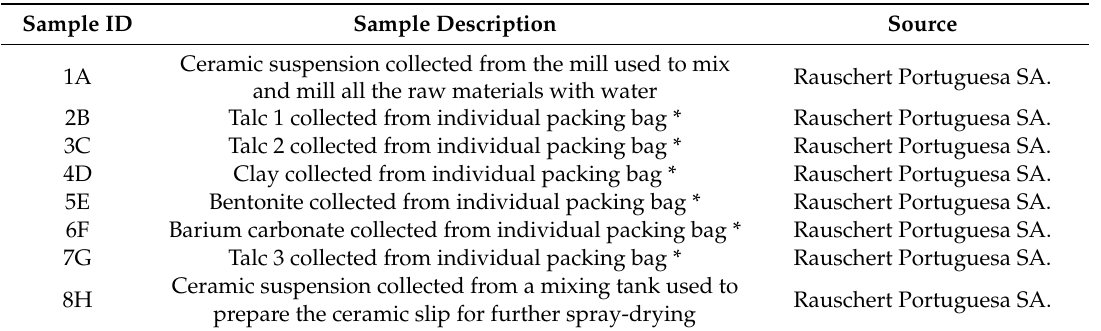
Table 1. Description and characteristics of studied samples.